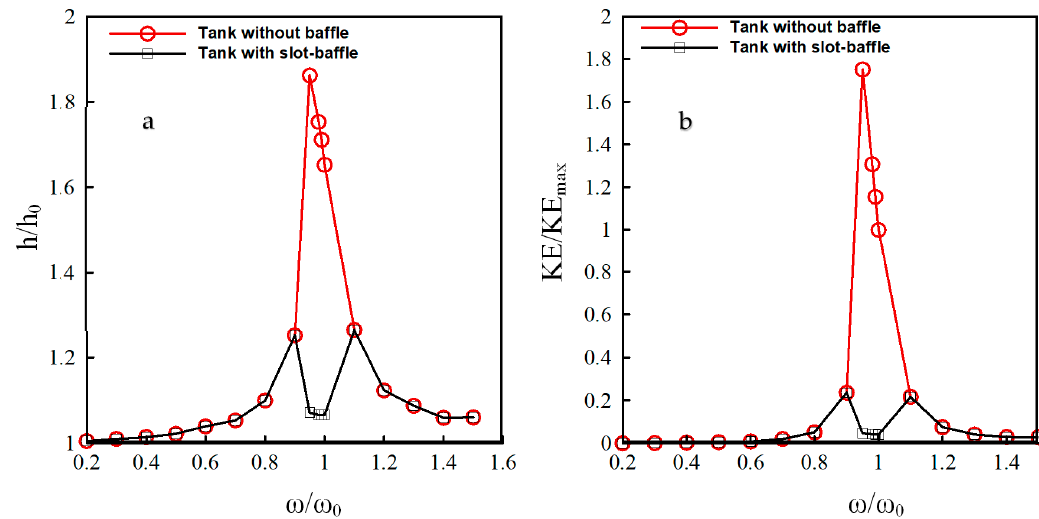
Figure 10. Variation of ( a ) the maximum water depth at the tank wall and ( b ) internal kinetic energy of the liquid with oscillation frequency. Here, ω 0 is the natural frequency of the partially filled rectangular tank.